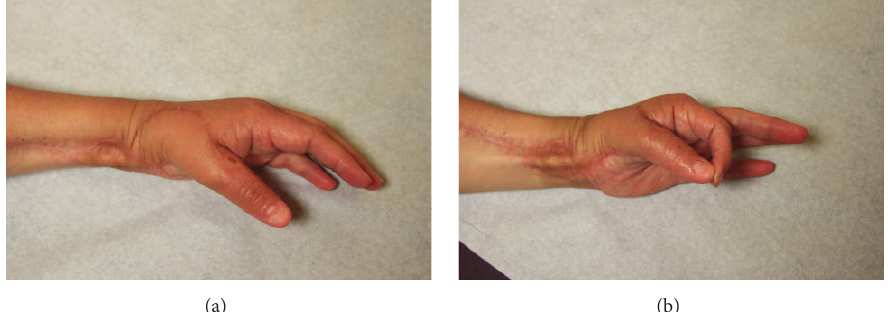
Figure 8: Postoperative clinical photographs. (a) Dorsal view of the thumb in a resting position. (b) Demonstration of the patient performing a functional pinch to the index